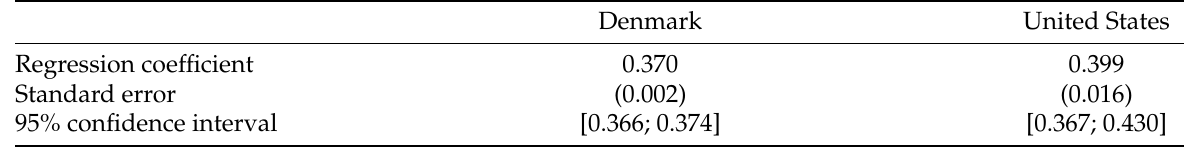
Table 2: Reproduction of panel 3, Table 4, in Andrade and Thomsen